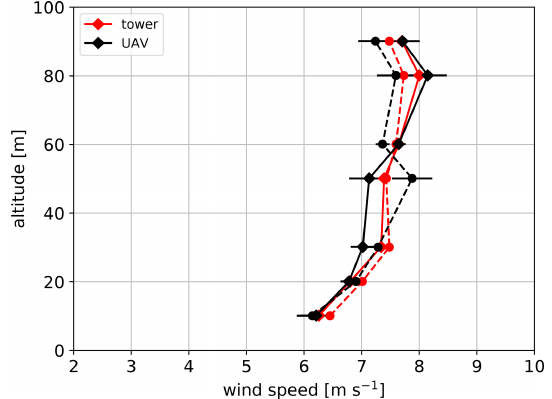
Figure 8. Comparison of drone tower to reference data from the tower for flight no. 61 (solid line) and no. 62 (dashed line). The error bars represent the rms deviation that was determined for each individual quadrotor in Sect. 5.3.